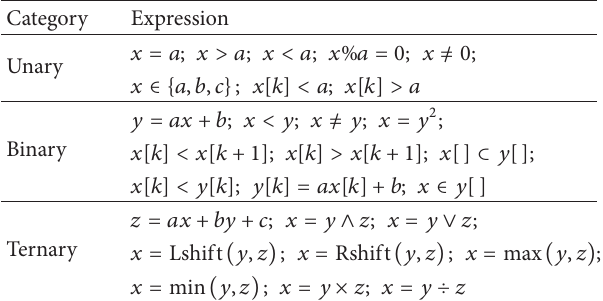
Table 1: Relationships of invariants considered in this paper.